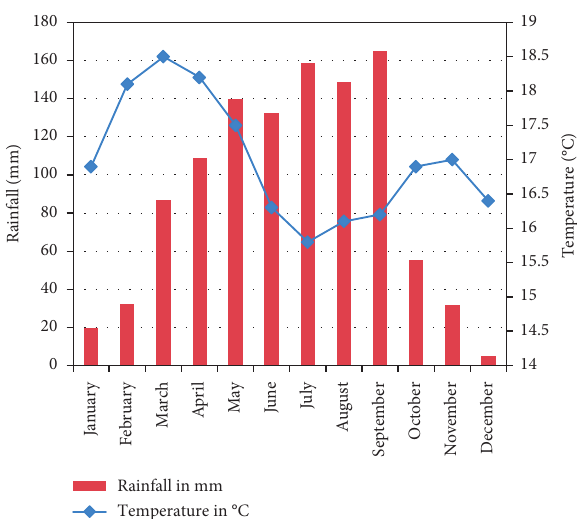
Figure 2: Mean monthly rainfall and temperature values of the study